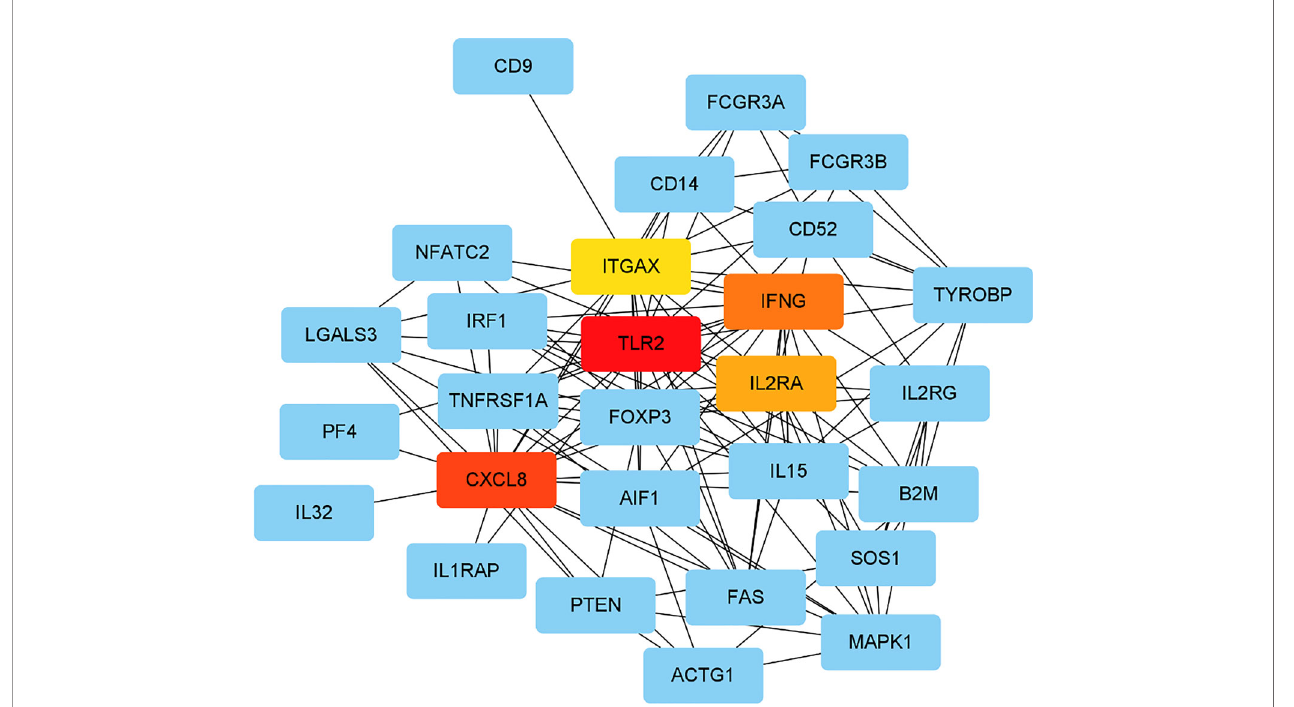
FIGURE 3 | Identi fi ed the hub gene by Cytohubba. In the network, TLR2,CXCL8, IFNG, IL2RA, and ITGAX were calculated as the top 5 hub genes.